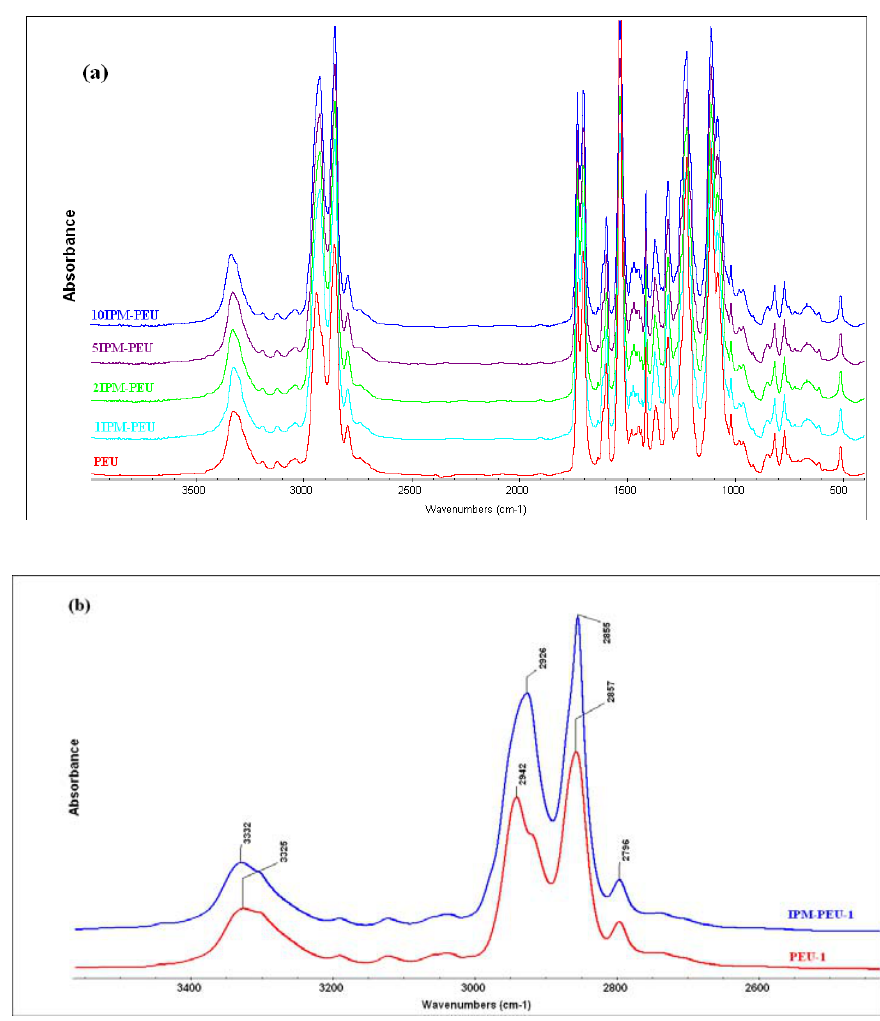
Figure 2. (a) FTIR Spectra of polyether-urethanes loaded with IPM (b) FTIR spectra of IPM-PEU in the range 3,500-2,500 cm -1